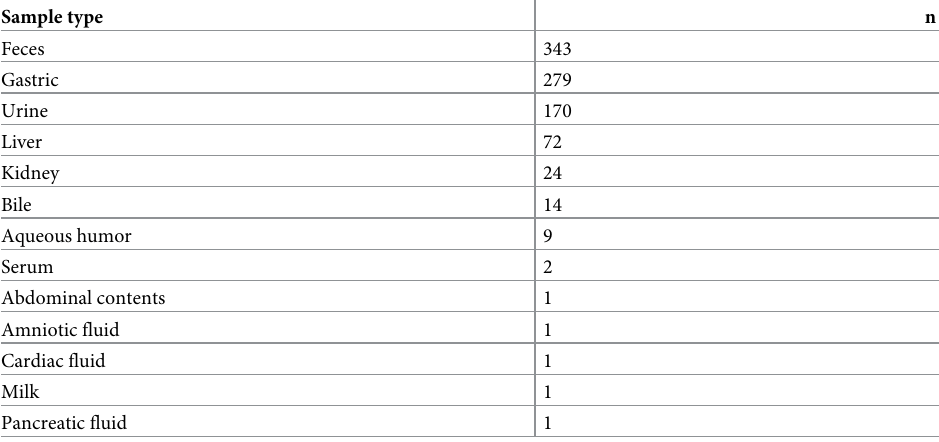
competition between radiolabeled STX and STX in the sample or in standards (NIST RM 8642) for binding to the voltage-gated sodium channel, the pharmacological target of STX, to determine the total STX-like activity of the sample. The RBA detection limit was approxi- mately 3.0 ng STX equivalents/g for solid samples and 1.0 ng STX equivalents/mL for fluid samples. ELISA methods used a commercially available, direct competitive STX kit (Biosense Table 2. Distribution of sample types collected and analyzed for